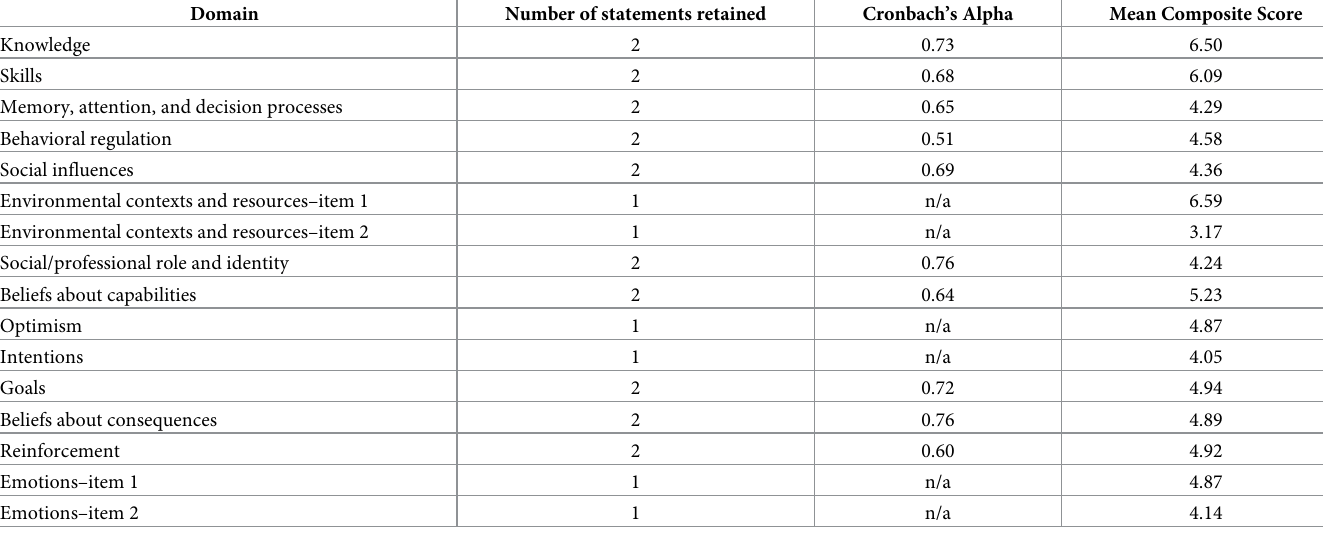
Table 1. Cronbach’s alpha and composite scores for the Theoretical Domains Framework: Diagnostic 1 survey about behavioral intentions.